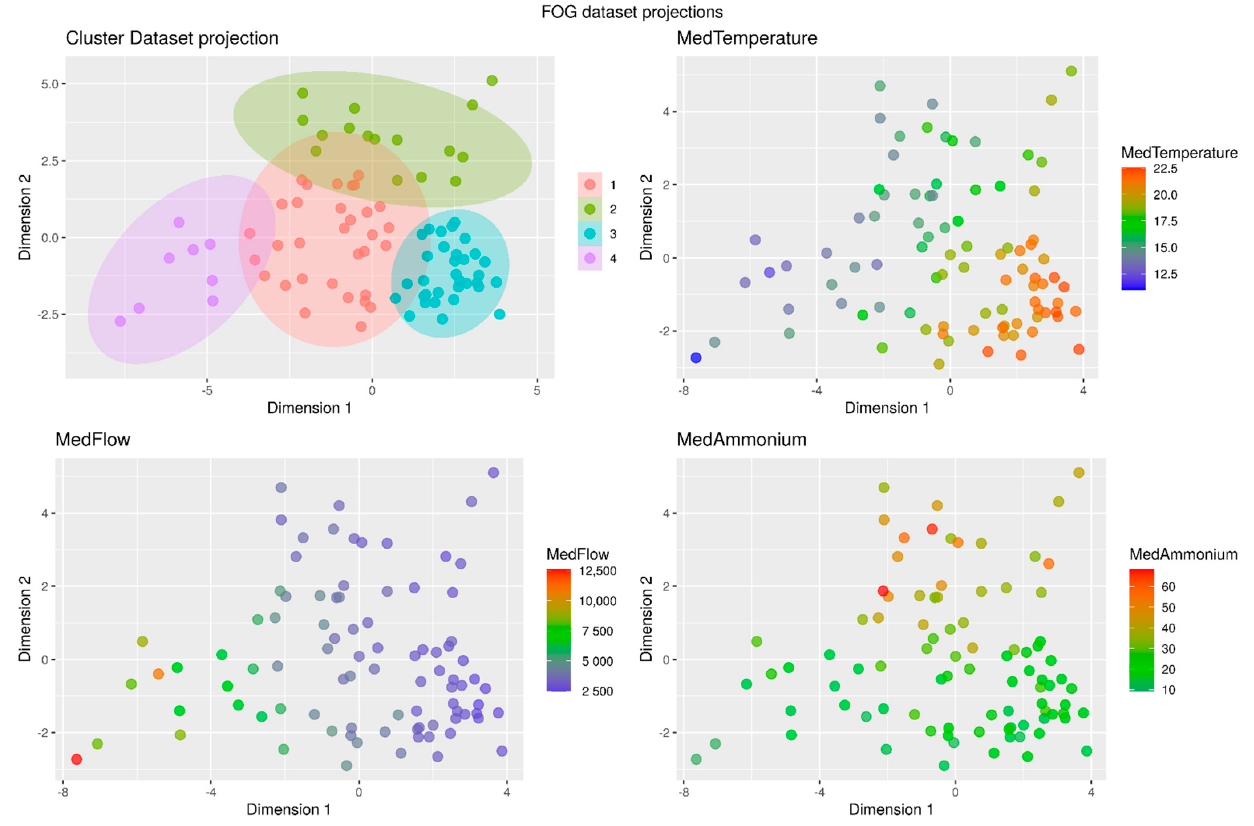
Figure 6. Comparing dataset PCA projection with clustering variables.